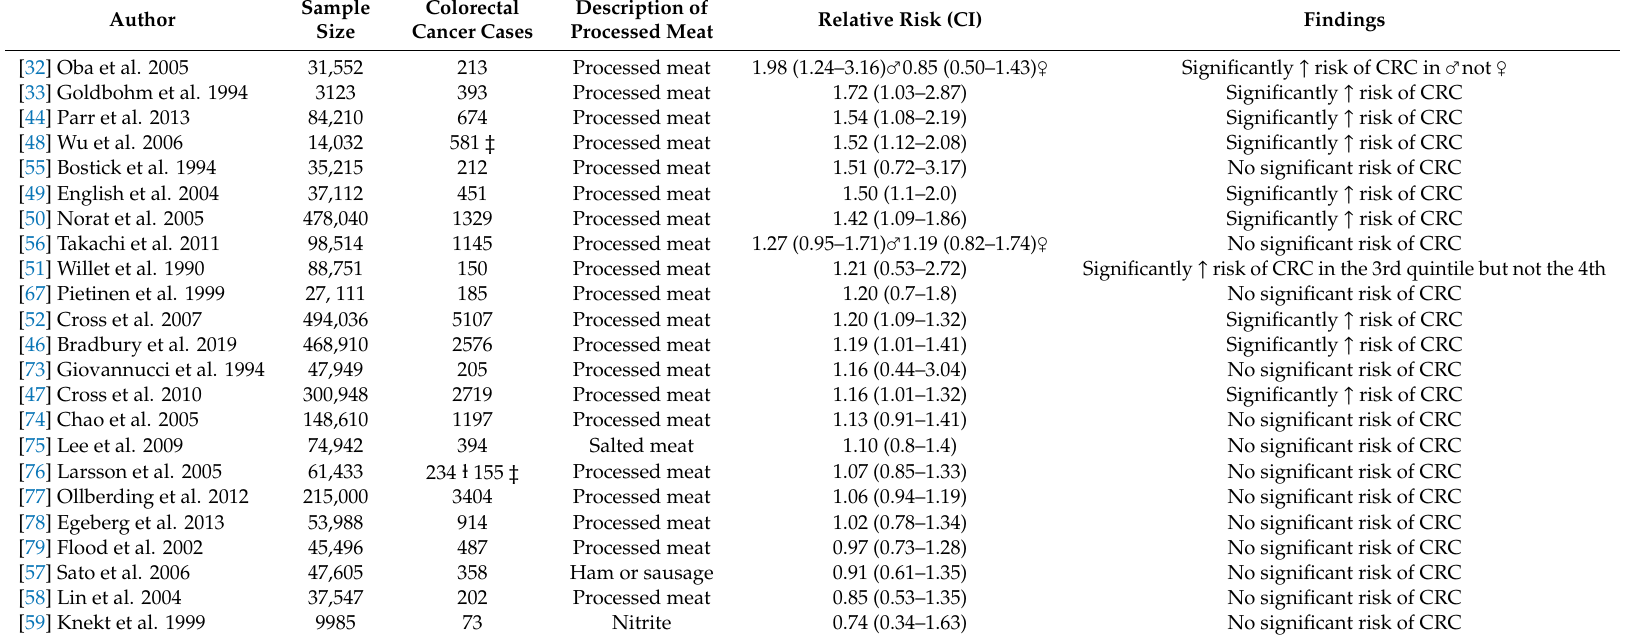
Table 2. Characteristics of prospective human studies assessing colorectal cancer and processed meat consumption